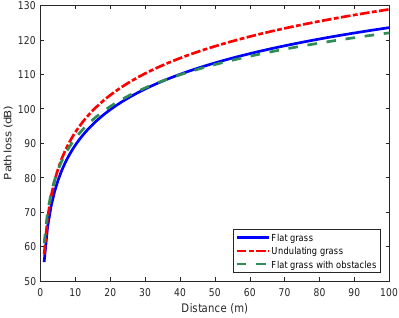
Figure 8. Path loss models with different terrain factors ( H t = H r = 5